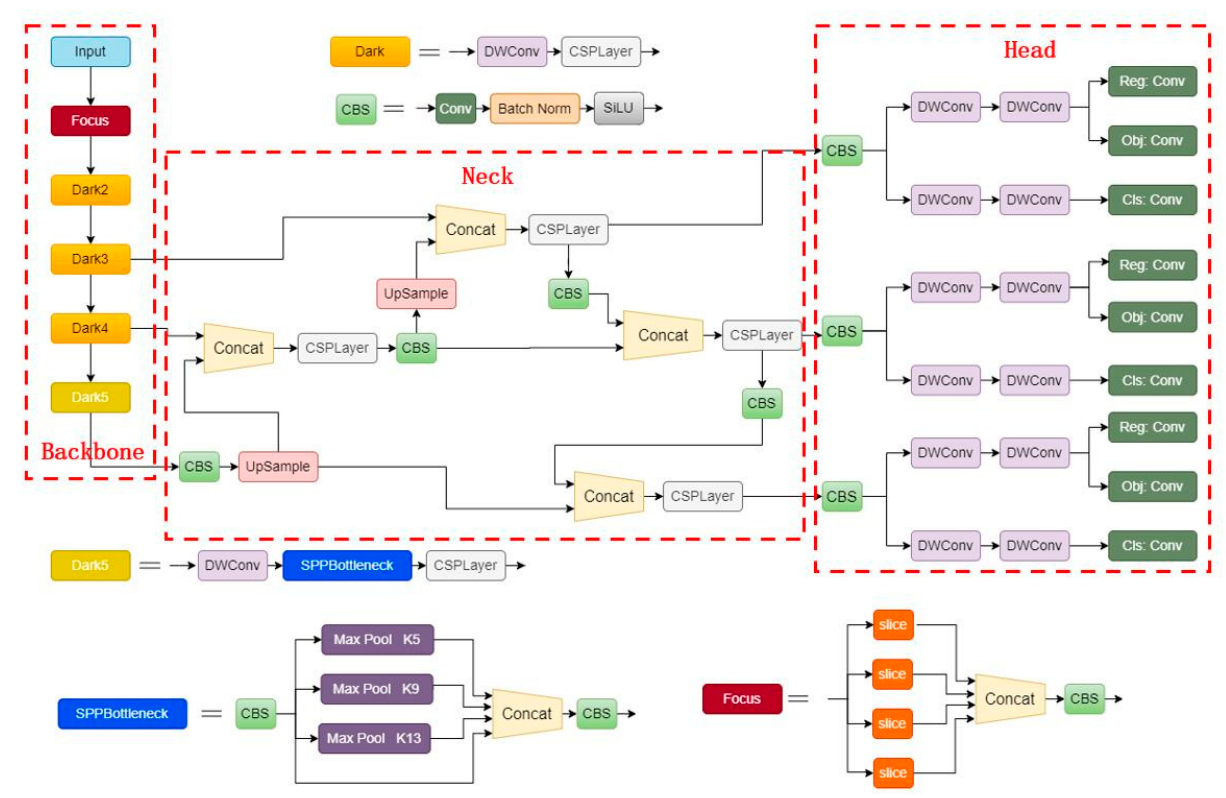
Figure 3. YOLOX-Nano network structure.